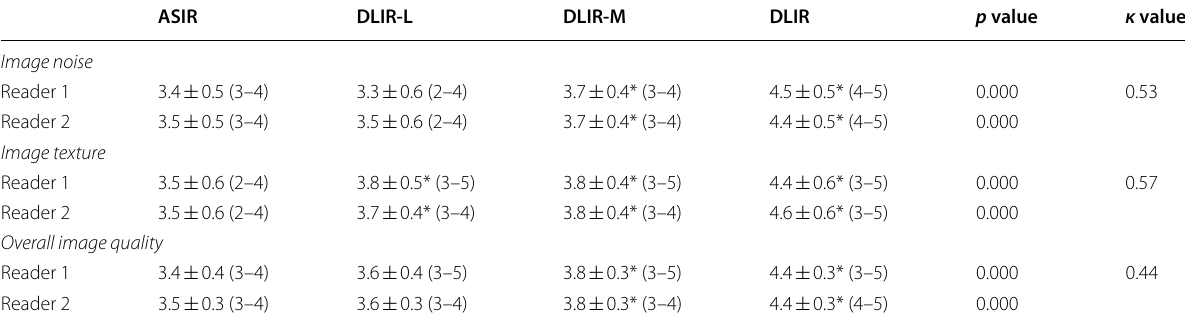
*Mean statistical higher than ASIR-V ASIR, adaptive statistical iterative reconstruction-Veo; DLIR, deep learning image reconstruction (low strength, DLIR-L; medium strength, DLIR-M; high strength, DLIR-H)